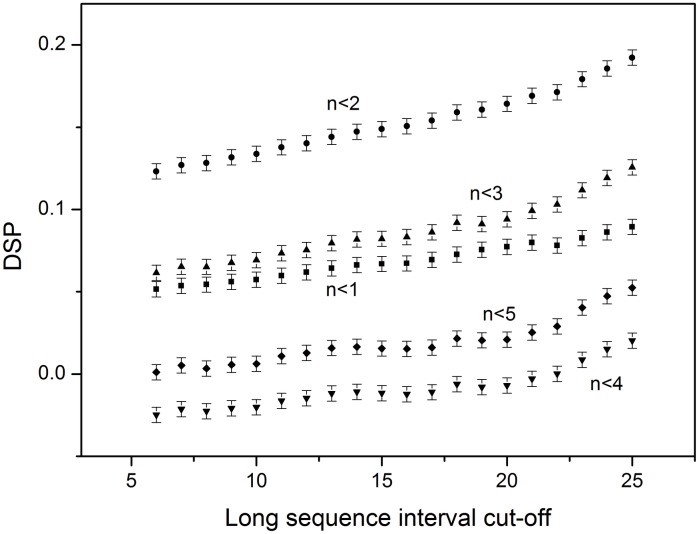
DSP against the long-sequence-interval cut-off.Filled squares represent the short-sequence-interval cut-off: Ns = 1 (n < 1); filled circle: Ns = 2 (n < 2); filled triangle: Ns = 3 (n < 3); filled inverted triangle: Ns = 4 (n < 4); filled rhombus: Ns = 5 (n < 5). Error bars represent a 95% confidence interval. DSP, average difference of SP in the charged-residue arrangement pattern in a given sequence; NS, residue pairs separated by a short interval.